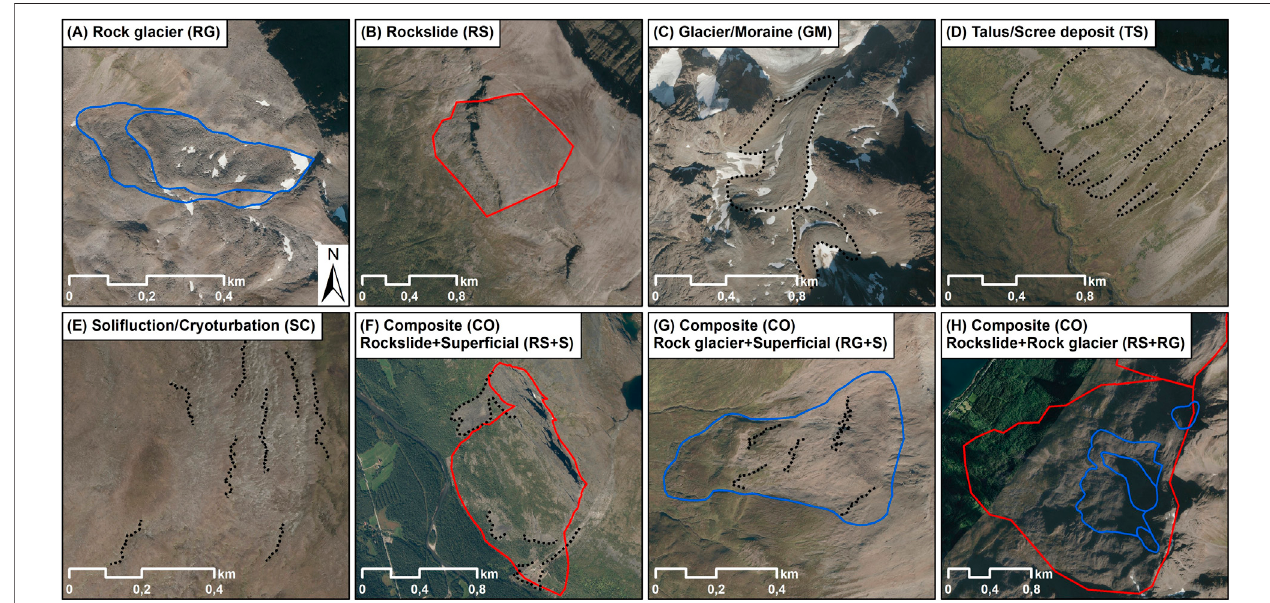
FIGURE 3 | Orthophotos with examples of the landform categories. Locations (A – H) of these detailed maps are shown in Figures 1 , 4 . The lines highlight the indicative morphologic delineations (blue: rock glaciers; red: rockslides, dashed black: others morphologic features, in (C) : debris-covered glacier and ice-cored moraine; in (D) and (F) : gullies and talus cones; in (E) and (G) : soli fl uction lobes). Norge i bilder orthophotos from NMA (2020b).